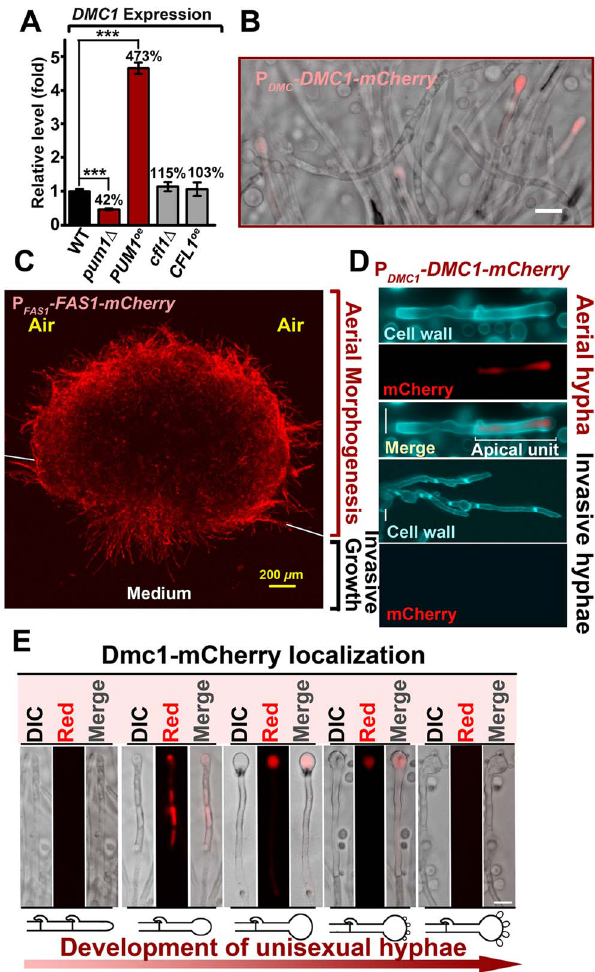
Figure 6. Unisexual meiotic progression is only observed in the Pum1-controlled aerial hyphal population. (A) Pum1, but not Cfl1, affects the expression of DMC1 during unisexual reproduction. (B) Dmc1 expression is associated with a portion of hyphal cells but not yeast cells. Scale bar: 20 m m. (C) Fas1 is exclusively expressed in the hyphal population and it is used as a molecular indicator to visualize the hyphal population in a mating colony. A side-view of a single-cell derived colony (3 days old) shows the topology of Fas1-expressing hyphal population in the community. (D) Details of the morphology and Dmc1 expression for aerial hyphae and root hyphae (invasive hyphae) from the unisexual mating community are shown. Fungal cell wall was stained blue with calcofluor white. Dmc1 expression was exclusively observed in aerial hyphae but not in invasive hyphae (more than 200 invasive hyphae were examined). Scale bar: 10 m m. (E) The dynamics of Dmc1-mCherry monitored during unisexual development. Scale bar: 10 m m. The localization patterns of Dmc1 in the figure are represen- tative for each given stage of development ( . 40 hyphae for each stage were